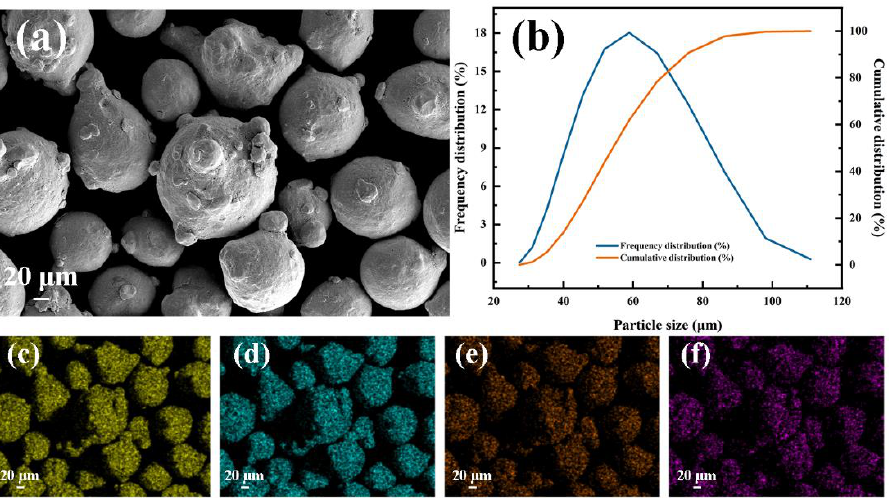
Figure 1. Inconel625 alloy powders: ( a ) SEM image; ( b ) particle size distribution; main element mapping: ( c ) Ni, ( d ) Cr, ( e ) Mo, ( f ) Nb. Table 1. Chemical composition (wt.%) of Inconel625 powder and 27SiMn steel substrate.